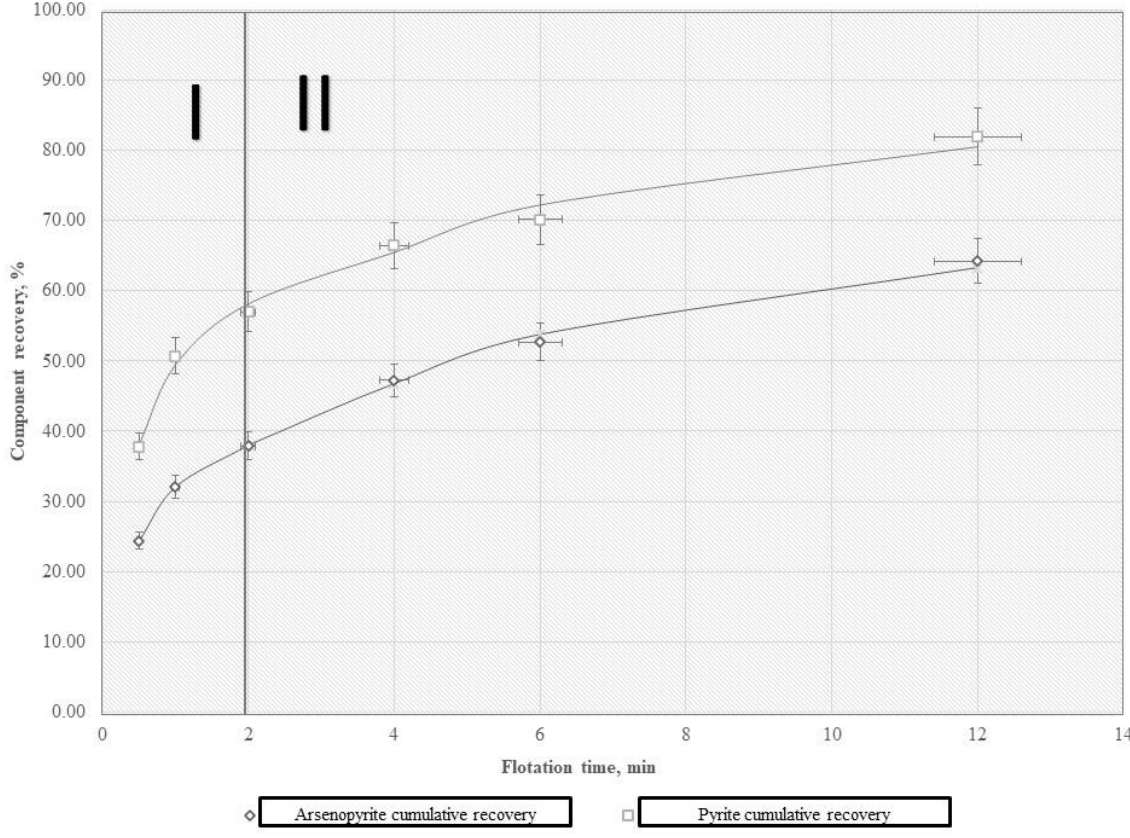
Figure 4. Recovery profiles for flotation with PNBX application.